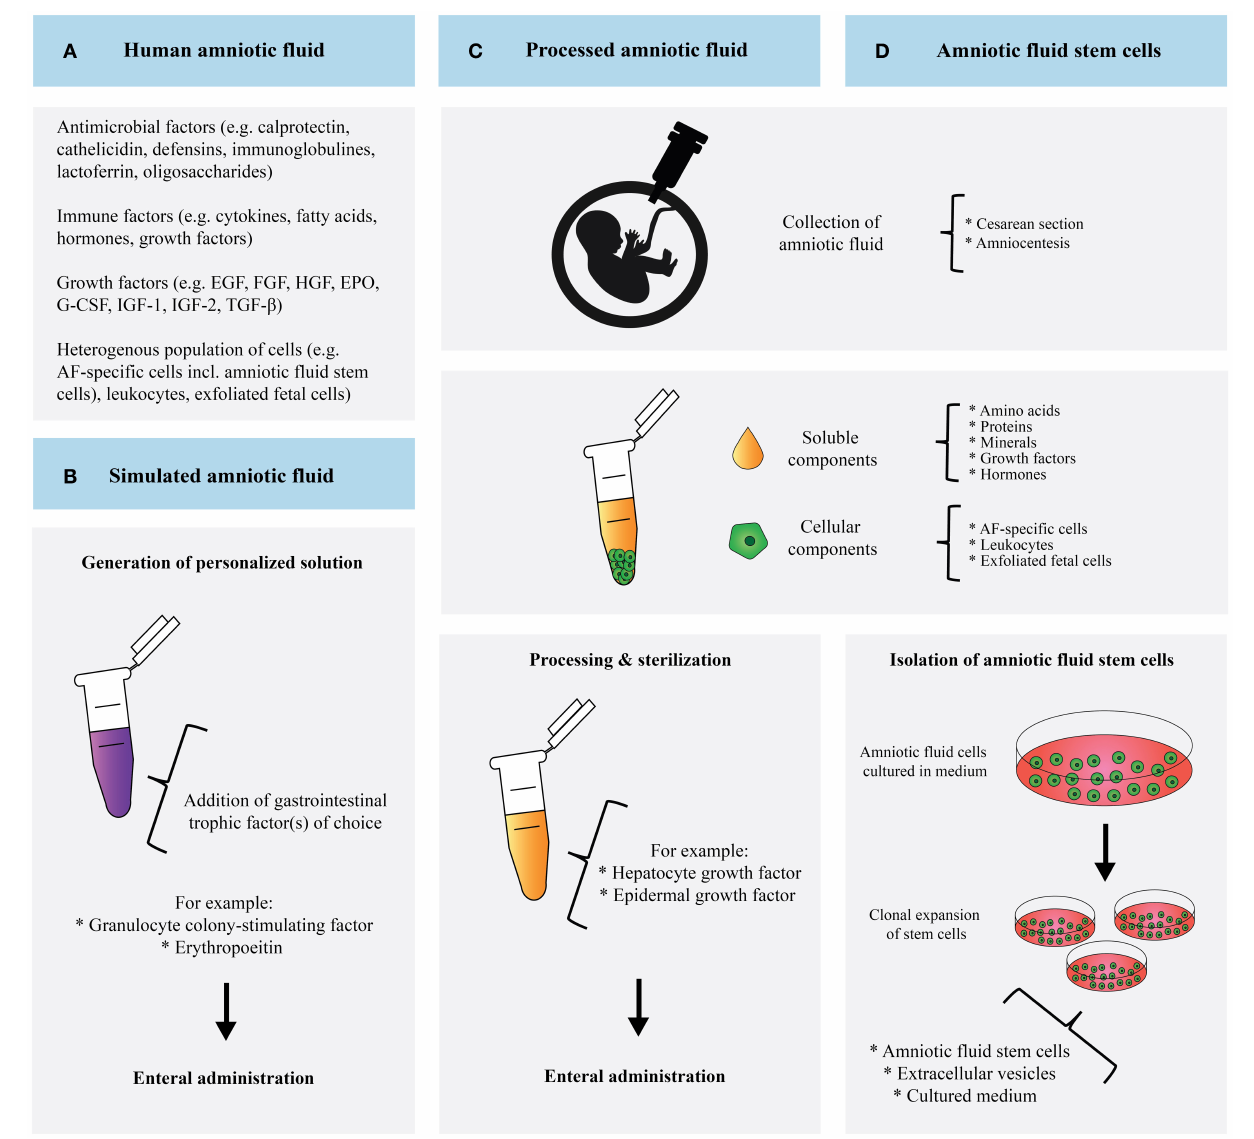
and hematocrit levels between the treatment and control